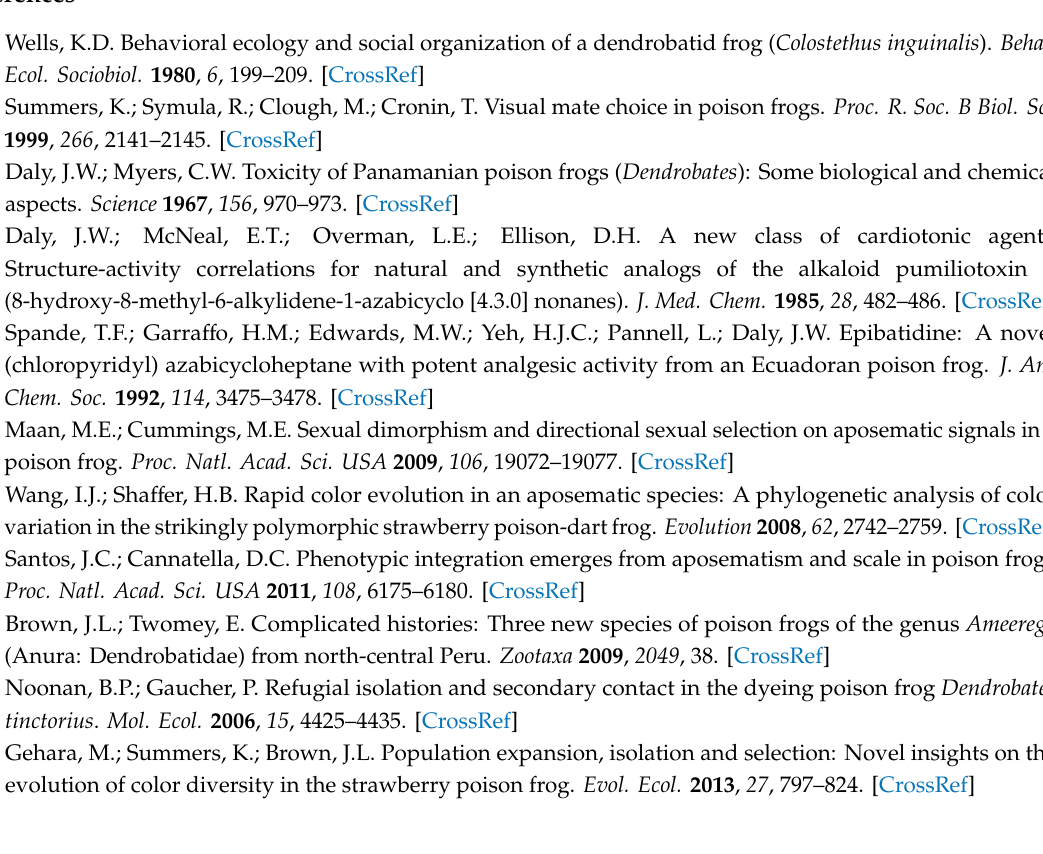
BEAST 2, Table S3: IUCN Red List categories of dendrobatoids by genus, Table S4: IUCN Red List categories of dendrobatoids by